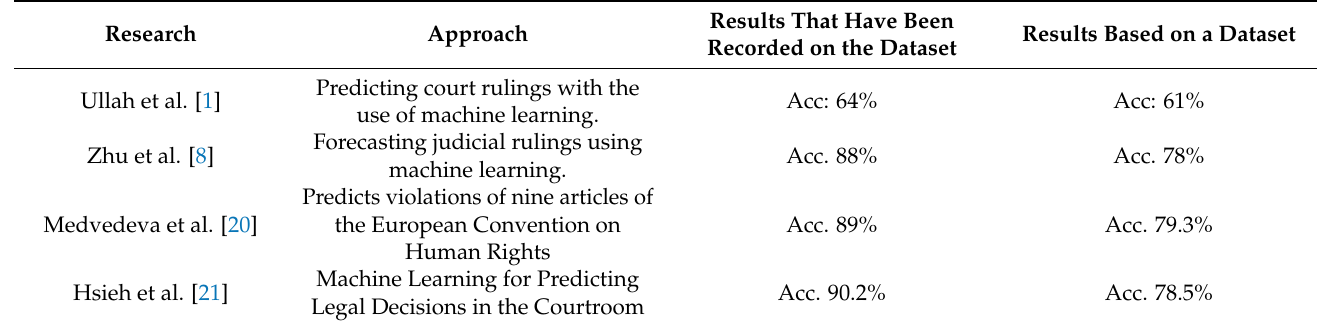
Table 14. Comparison of the LSTM+CNN model to comparable